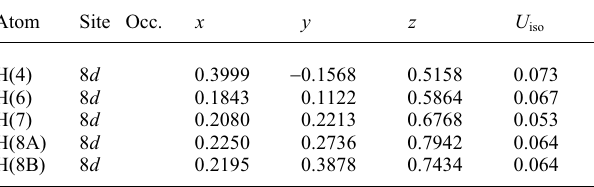
Table 2. Atomic coordinates and displacement parameters (in Å 2 )